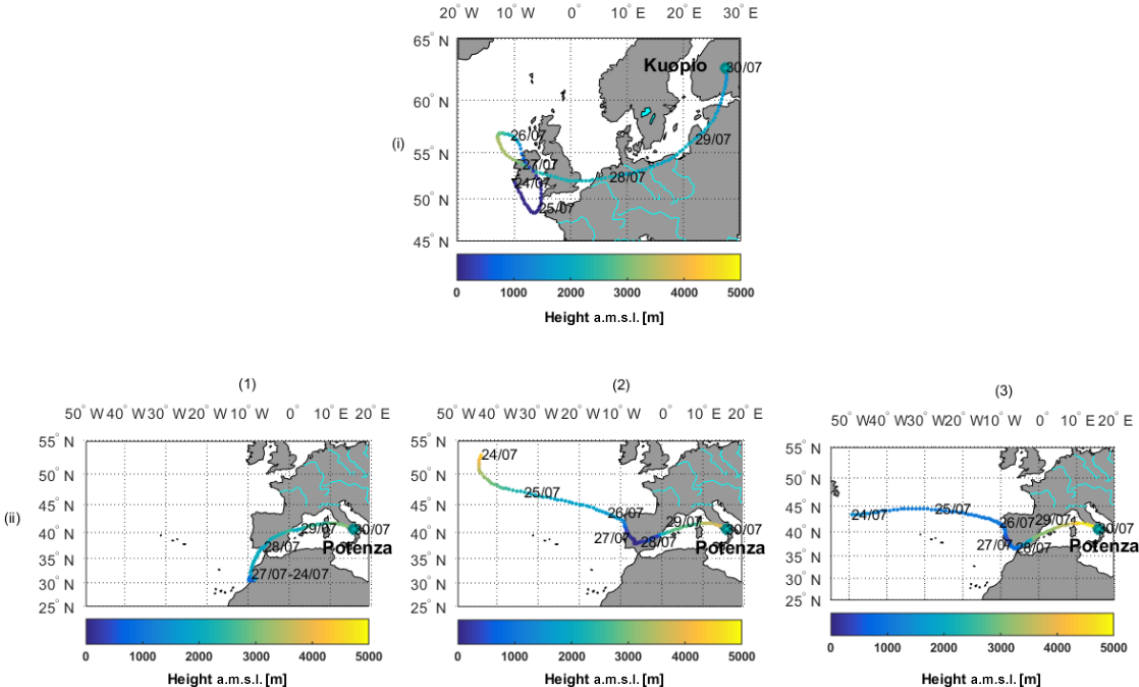
Figure 4. HYSPLIT (GDAS Meteorological Data) 6d (144h) air-mass backward trajectory ending on 30 July 2015 over the lidar stations in (i) Kuopio (62.74 ◦ N, 27.54 ◦ E) at 1500m.a.s.l. (19:00UTC) and (ii) Potenza (40.60 ◦ N, 15.72 ◦ E) at (1) 3000, (2) 4000, and (3) 5000ma.s.l. (21:00UTC) using the model vertical velocity as a vertical motion calculation method. The color bar indicates the trajectory’s height above mean sea level for each hour of its